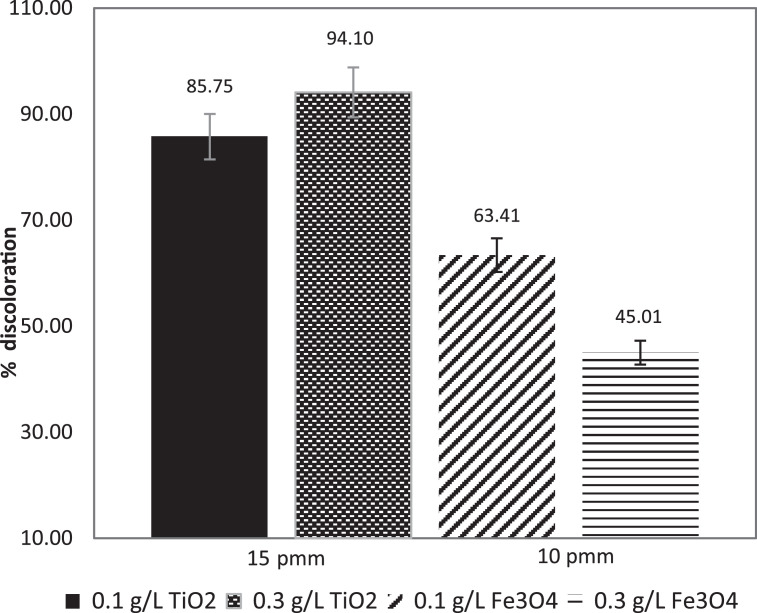
Comparison of MB discoloration under natural solar test at pilot scale, by of TiO2 and Fe3O4 [catalysts] = 0.1 g/L and 0.3 g/L.